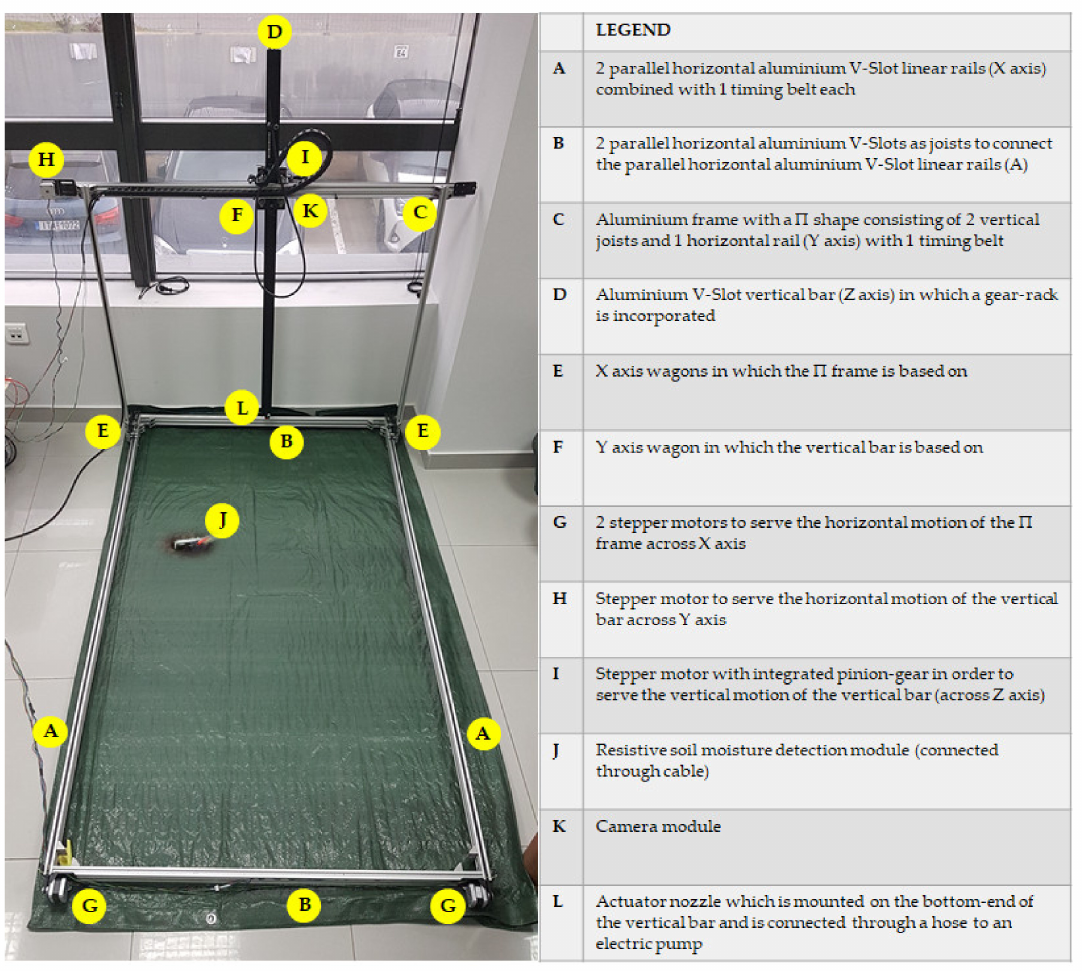
Figure 2. View of the assembled CityVeg platform, indicating the position of each specific part.